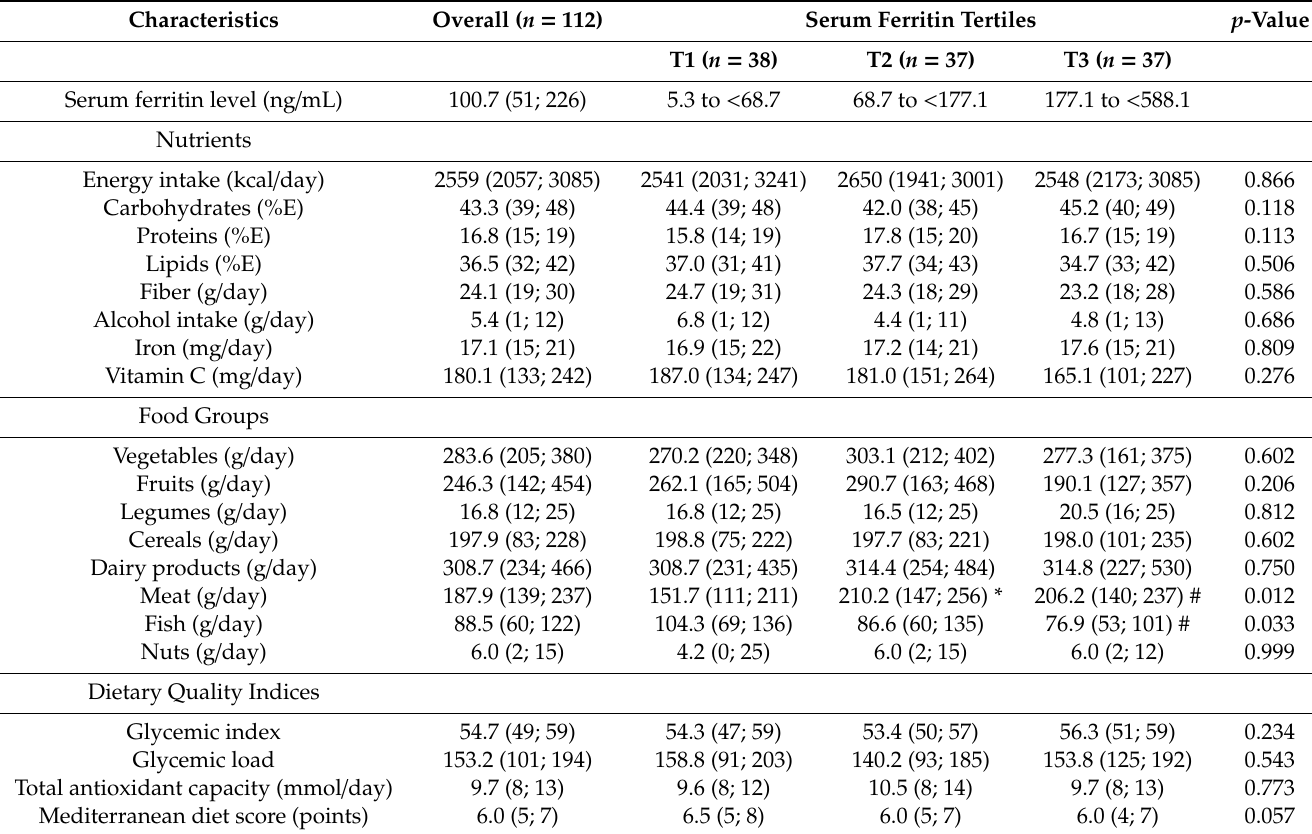
Table 2. Description of the nutrient and food consumption according to sex-specific serum ferritin